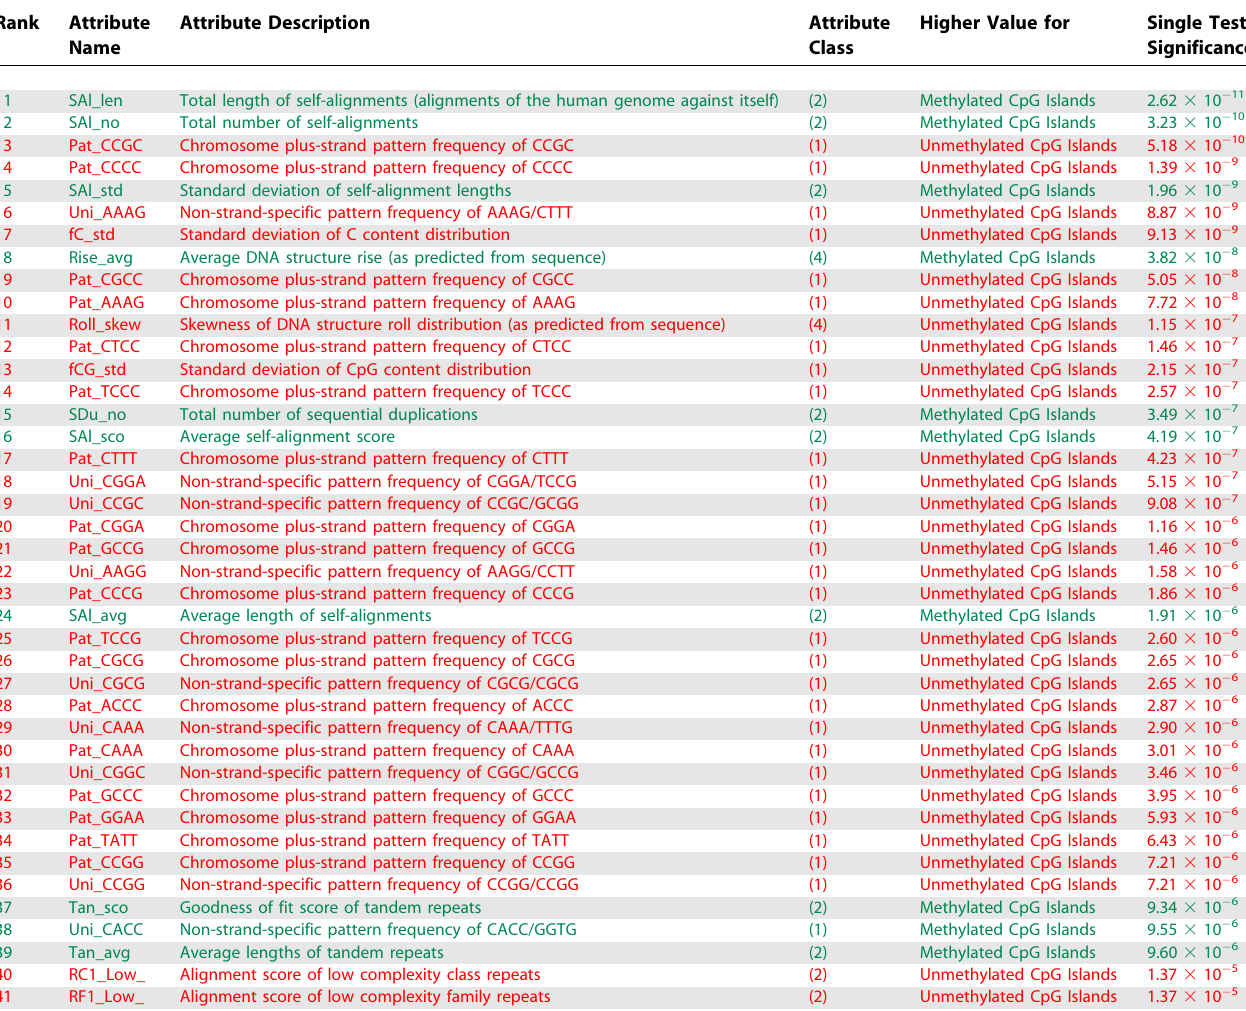
Table 1. DNA-Related Attributes Differ Significantly between Methylated and Unmethylated CpG